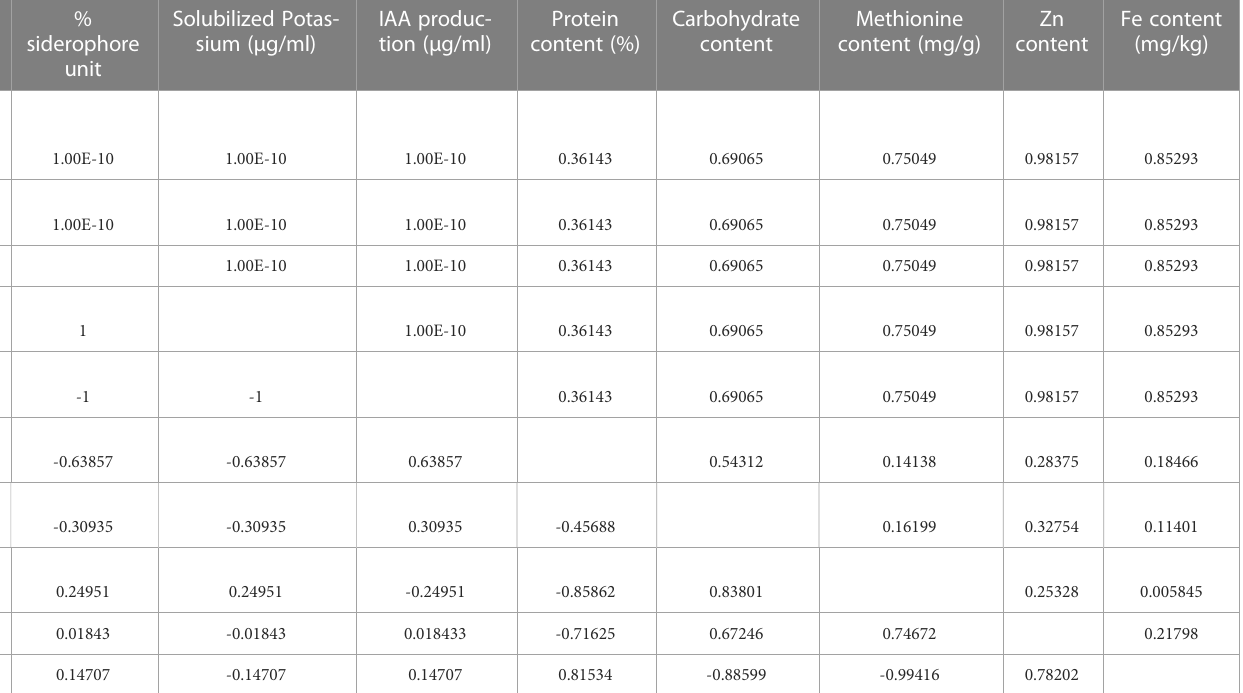
TABLE 5 correlation among PGP traits of both bioinoculants and nutritional